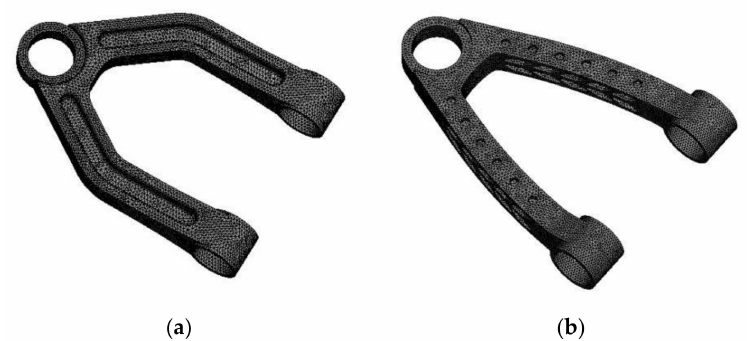
Figure 18. The finite element model (FEM) of the initial model and bionic model: ( a ) initial model; ( b ) bionic model.